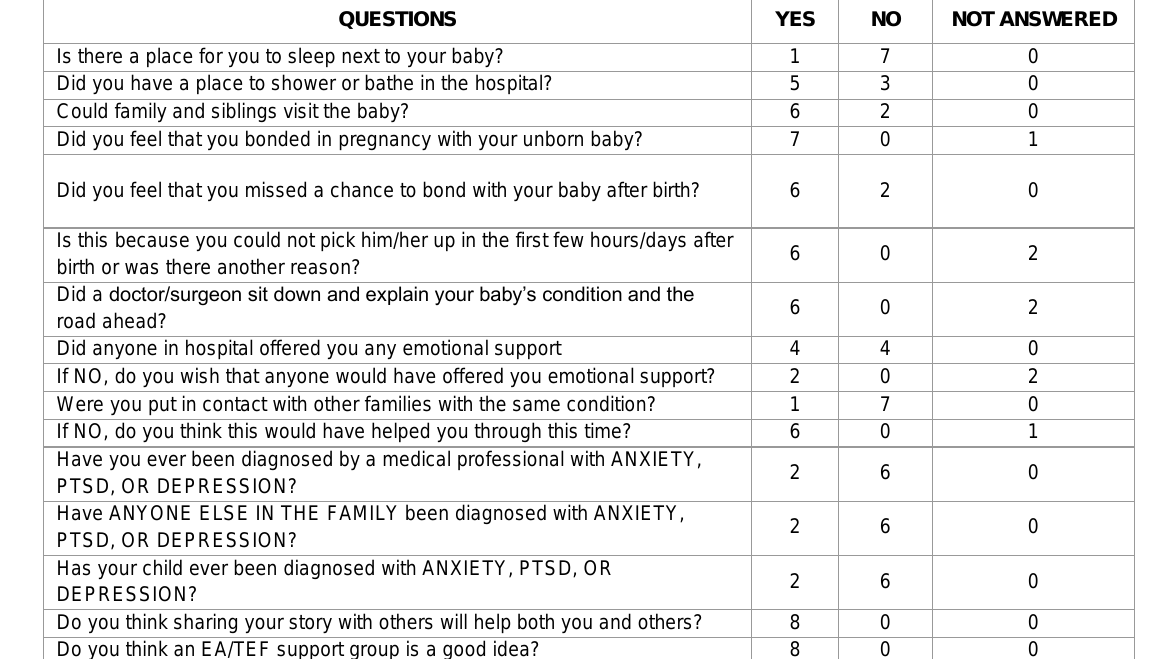
Table 3: Results from the emotional support part of the